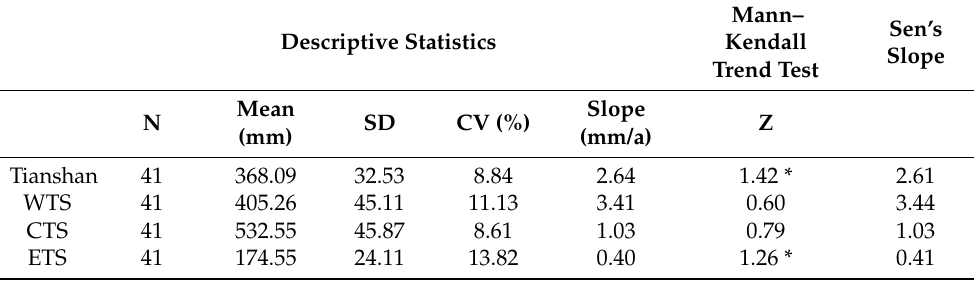
Table 5. Descriptive statistics and trend tests for annual precipitation.